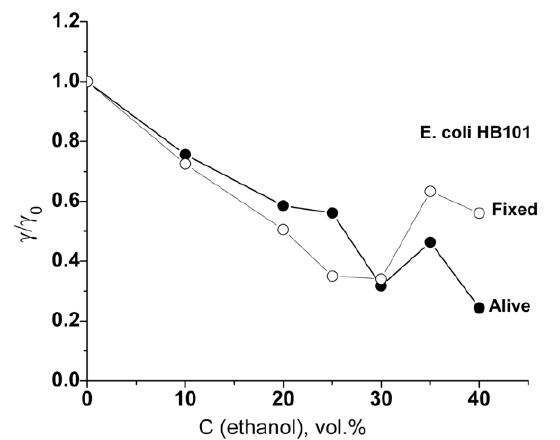
Figure 6. Dependencies of the relative electric polarizability ( g / g ) of E. coli HB101 on the concentration of ethanol 0 at low frequencies for live and fixed bacteria; g polarizability g at 0% ethanol: g g (fixed) = 4.9 rel. 0